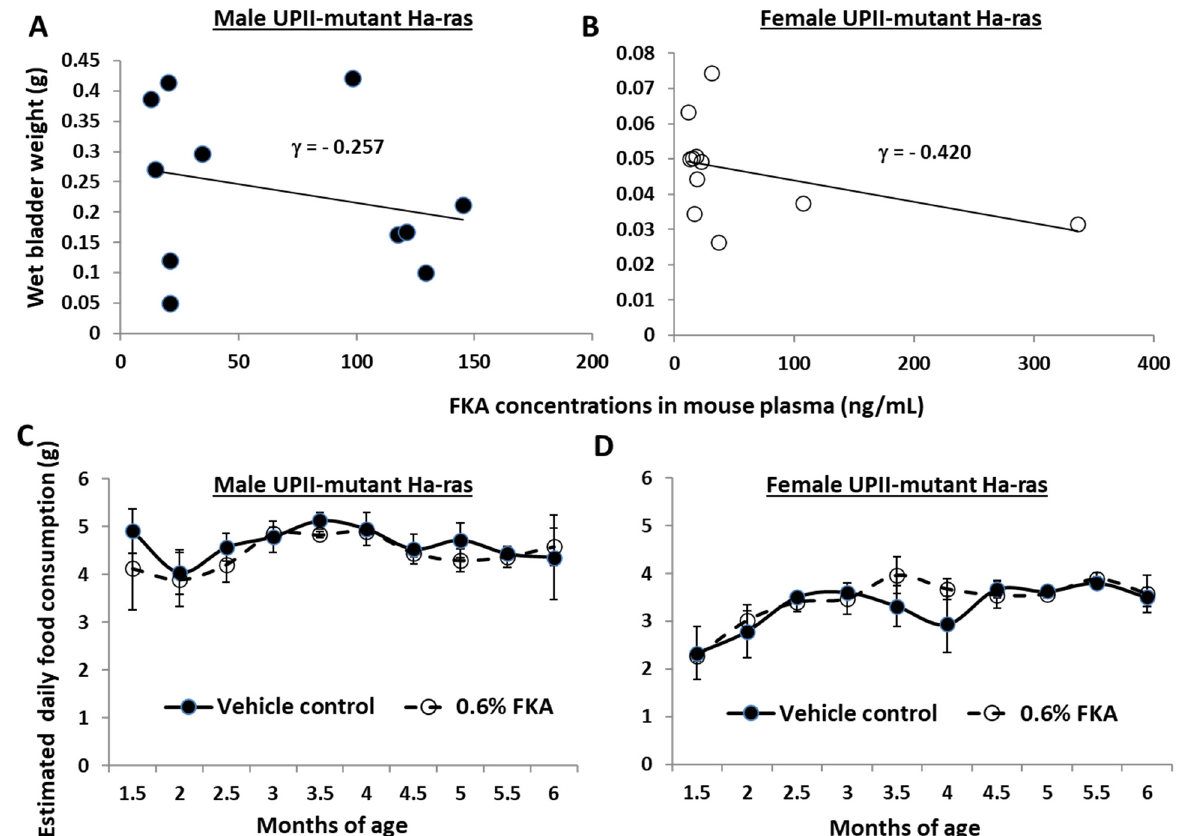
Figure 5. Plasma FKA concentrations are inversely related to tumor burdens. ( A ) Chromatographic separation of FKA was achieved using an ACQUITY UPLC (Waters, UK) with a reversed-phase ACQUITY UPLCTM BEP C18 column (1.7 μ m, 2.1 × 50 mm, Waters). FKA was monitored as a precursor ion with an m / z value of 315 and a fragment ion with a value at 181.14. Correlation analysis between FKA plasma concentrations and bladder weights in male ( A ) and female ( B ) UPII- mutant Ha-ras transgenic mice. The food consumption of male ( C ) and female ( D ) mice was weighted and changed every three